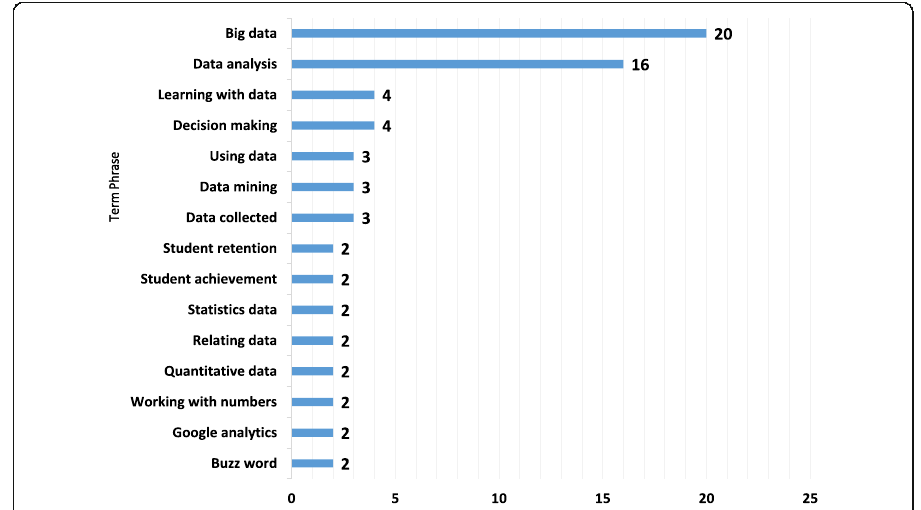
Fig. 3 Extracted words associated with